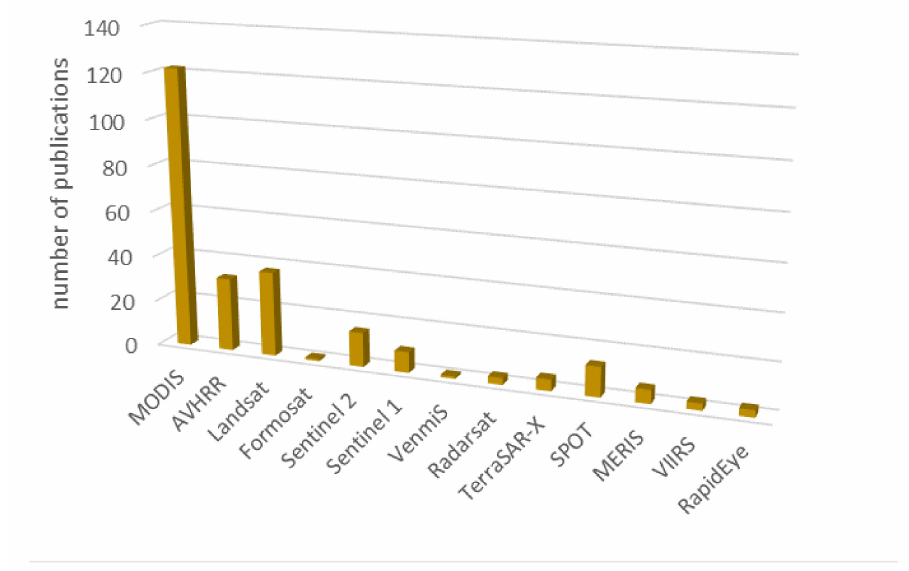
Figure 9. Number of publications with data provided by specific satellite sensors; most of the studies were based on more than one satellite dataset.